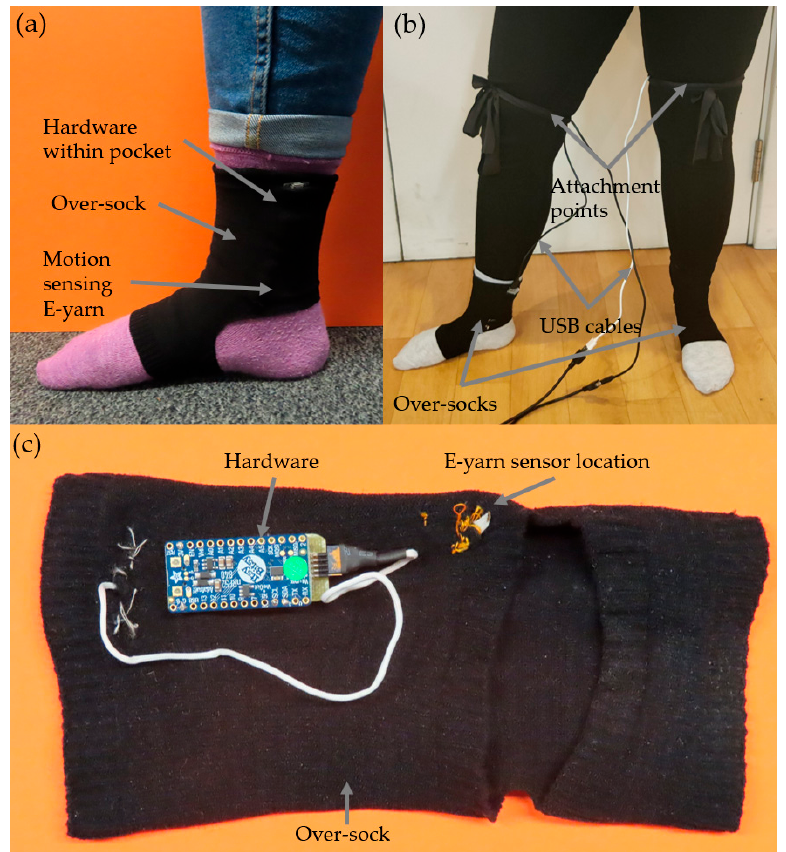
Figure 2. Photographs of the over-sock. ( a ) The over-sock contained one motion sensing E-yarn as well as the supporting hardware unit contained within a pocket. ( b ) Over-socks being worn during testing. The USB cables were attached to the participants using a stretchable fabric to prevent unnecessary strain on the hardware unit. ( c ) A photograph showing the inside of the over-sock. The hardware module has been removed from its pocket to better show its location within the sock. The E-yarn is secured within the socket with a few stiches (here shown using orange thread) to prevent